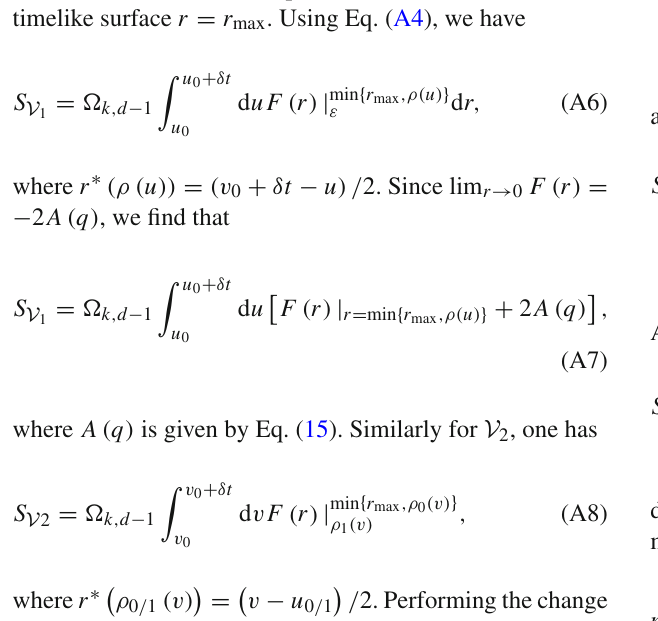
The region V 1 is bounded by the null surfaces u = u 0 , u = u 0 + δ t , v = v 0 + δ t , the spacelike surface r = ε , and